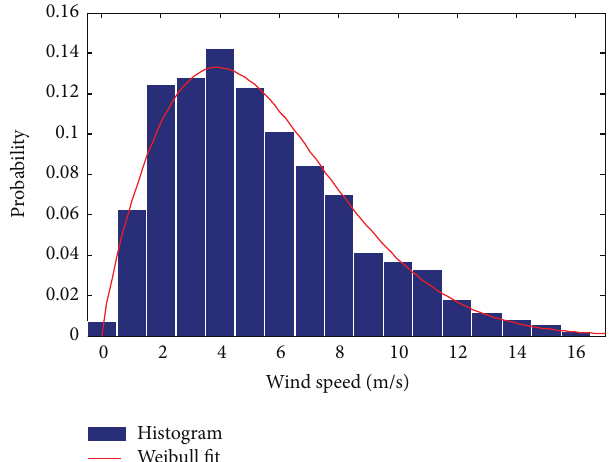
Figure 2: Histogram and Weibull PDF fit of wind speed raw data of Figure